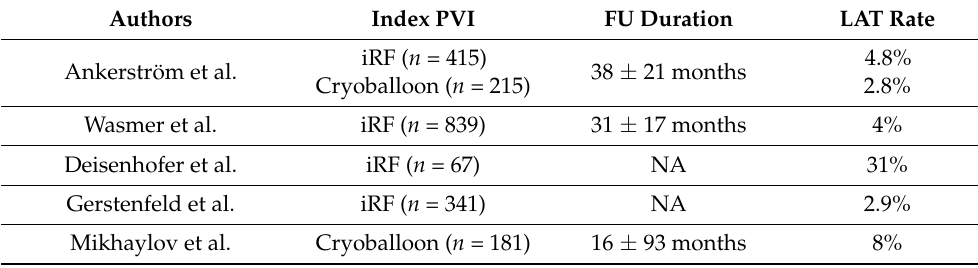
Table 4. Exert of current literature on left atrial tachycardia after PVI